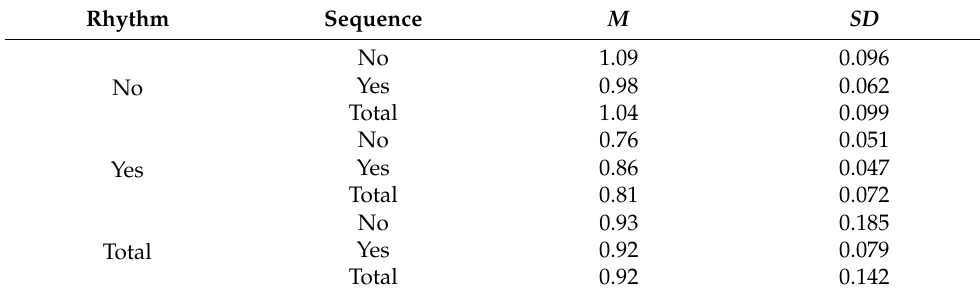
Table 11. Time Cross Statistical Analysis of Sequence and Rhythm.